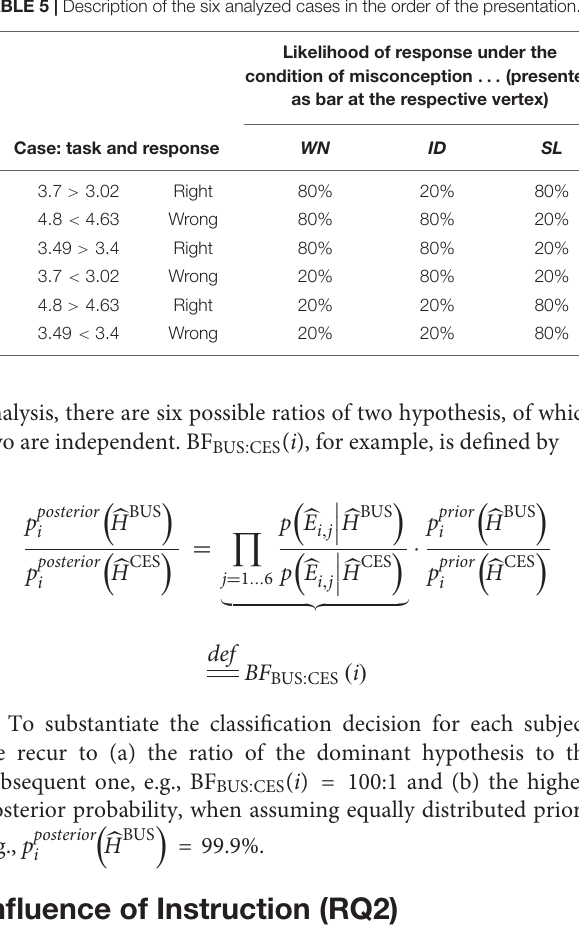
TABLE 5 | Description of the six analyzed cases in the order of the